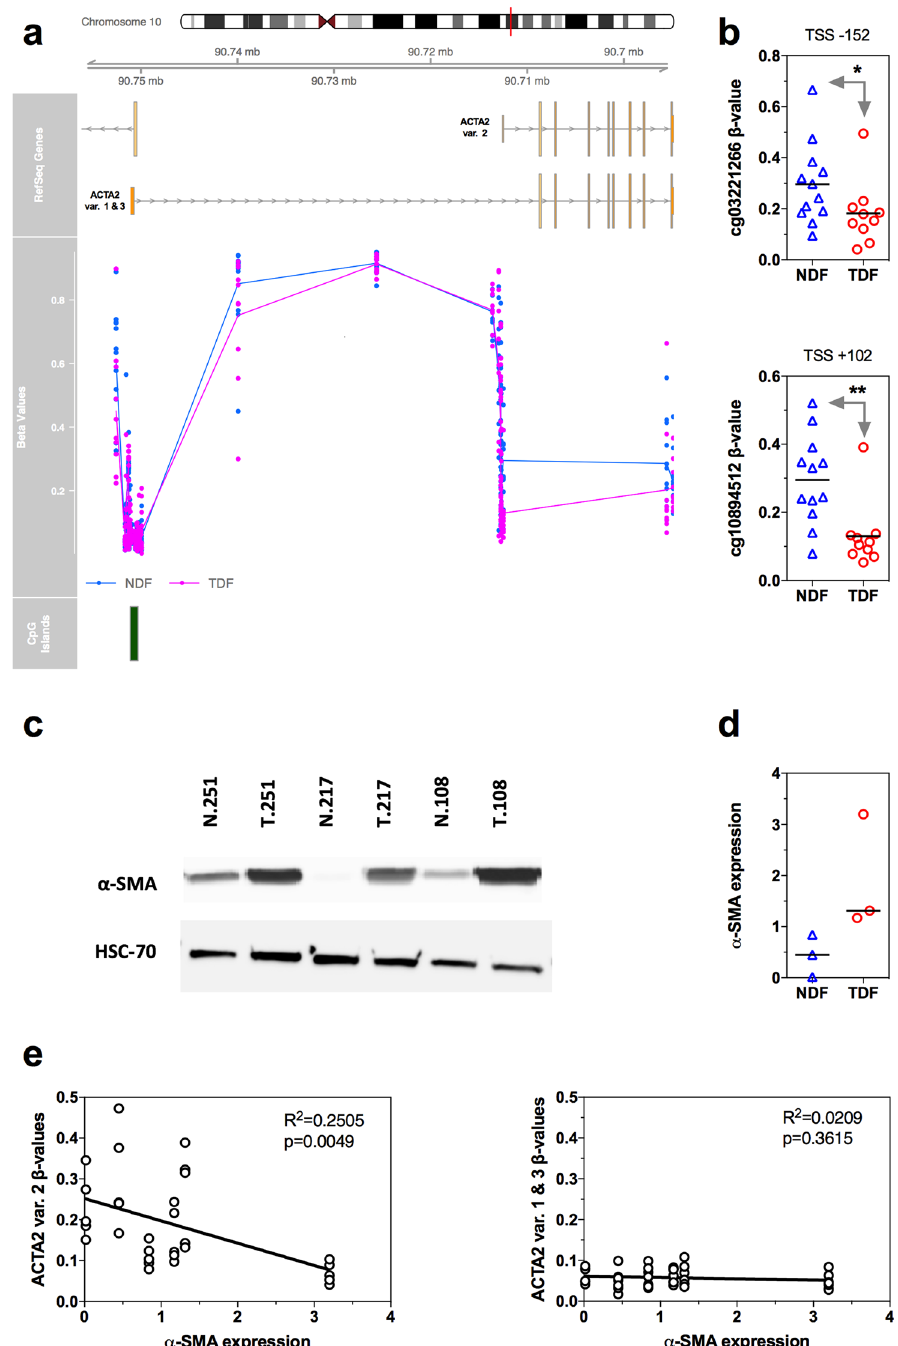
Figure 2. DNA methylation and expression of α -SMA (ACTA2). ( a ) The relative location of ACTA2 splice variants, individual β -values for all NDFs (blue circles) and TDFs (pink circles), and CpG islands. The lines for the β -values represent the average β -value for the NDF and TDF groups. ( b ) The β -values for all individual NDF and TDF samples for the probes cg03221266 and cg10894512 located at positions − 152 bp or + 102 bp respectively of the TSS of ACTA2 variant 2. * Benjamini-Hochberg adjusted p = 8.55 × 10 − 9 , ** Benjamini- Hochberg adjusted p = 2.46 × 10 − 19 . ( c ) Western immunoblot for α -SMA and the loading control HSC-70 for the three available patient matched pairs of NDFs (N.251, N.217 and N.108) and TDFs (T.251, T.217 and T.108). ( d ) Quantification of α -SMA protein expression for the three patient matched pairs. ( e ) Correlation between α -SMA protein expression and β -values for the probes about ACTA2 TSS of the splice variants for the three patient matched